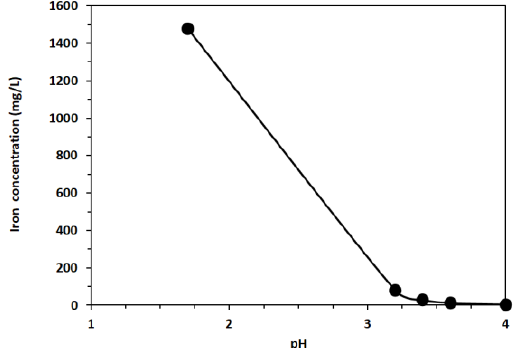
Figure 2. Soluble iron concentration in Bioleachate 1 in function of the pH.